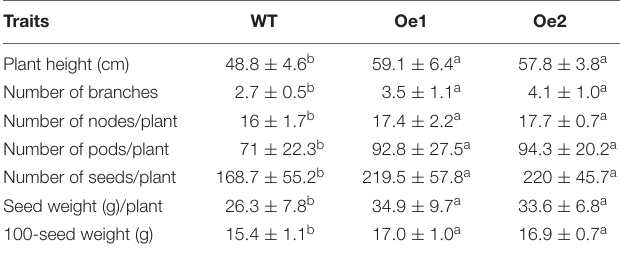
TABLE 1 | Agronomic performance of wild-type (WT) and GmPIP2;9-overexpre- ssion (Oe)